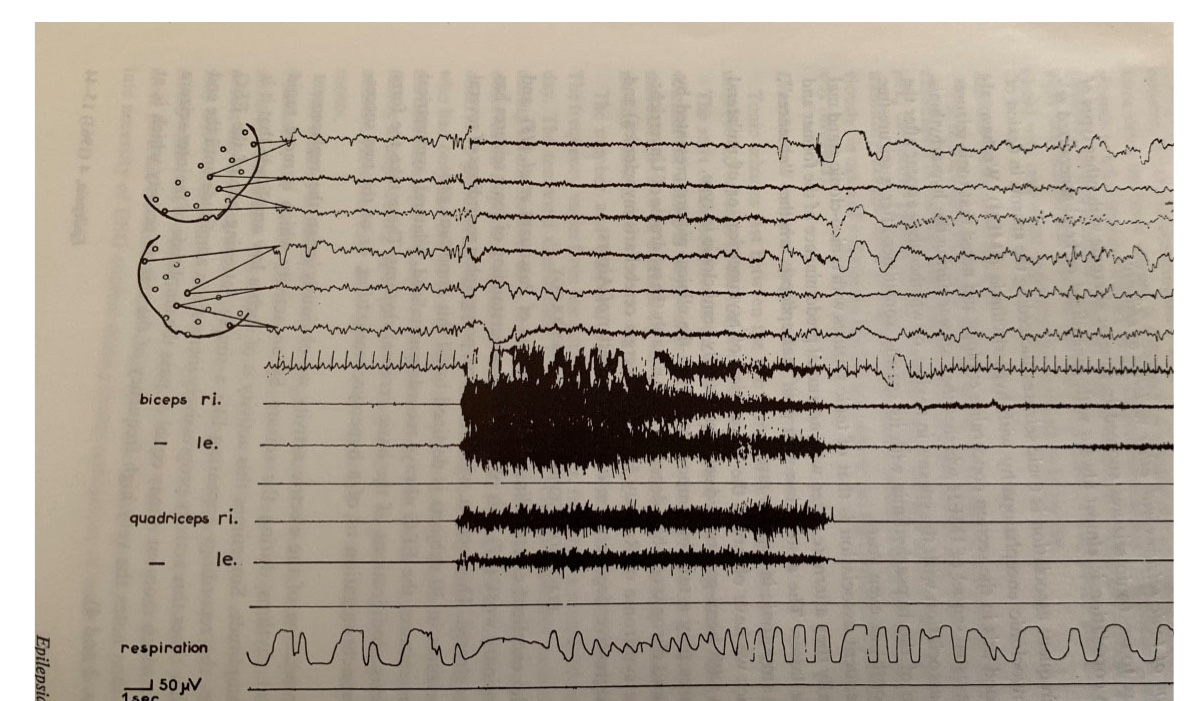
Figure 23. A generalized tonic epileptic seizure. In the EEG there is a brief polyspike and wave complex followed by a flattening during which there is increased muscle tone in the arms and legs without any myoclonus. There is a minor amount of post ‐ ictal EEG slowing. (Reproduced with a permission from Gastaut H, Roger J, Ouachi S, et al. An electro ‐ clinical study of seizures of tonic expression. Epilepsia 1963; 4: 15–44; published by Wiley ‐ Blackwell Publishing).